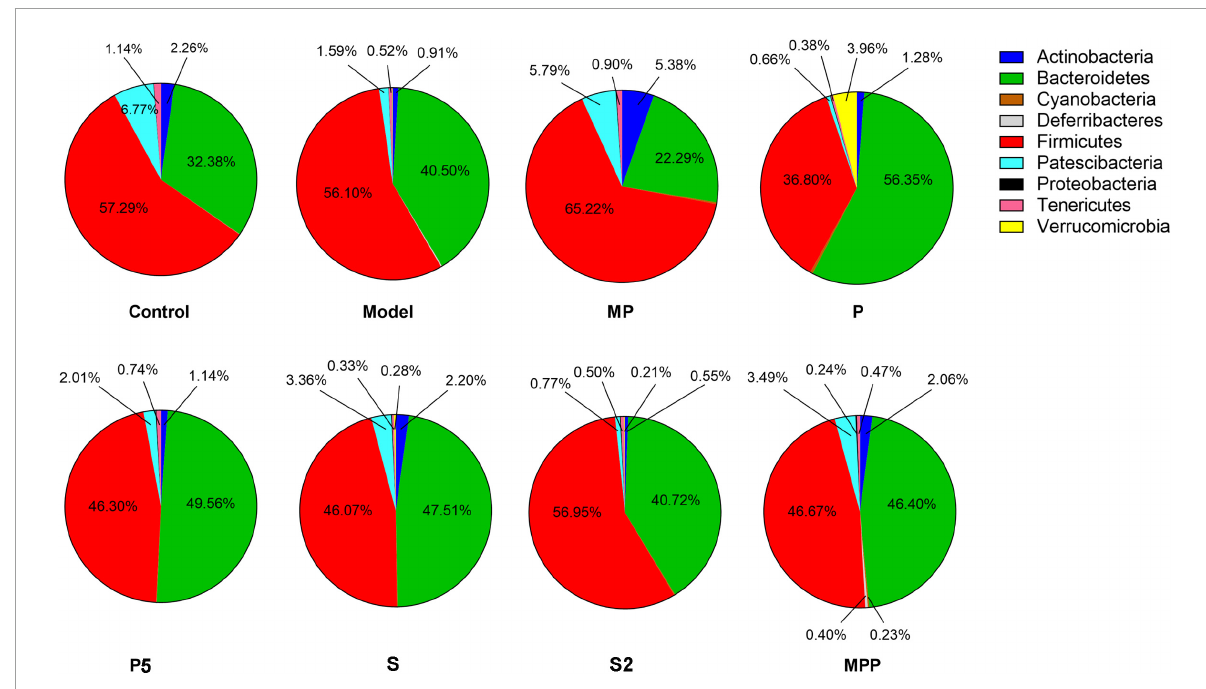
FIGURE3 The differences in the relevant abundance of gut microbial phyla among